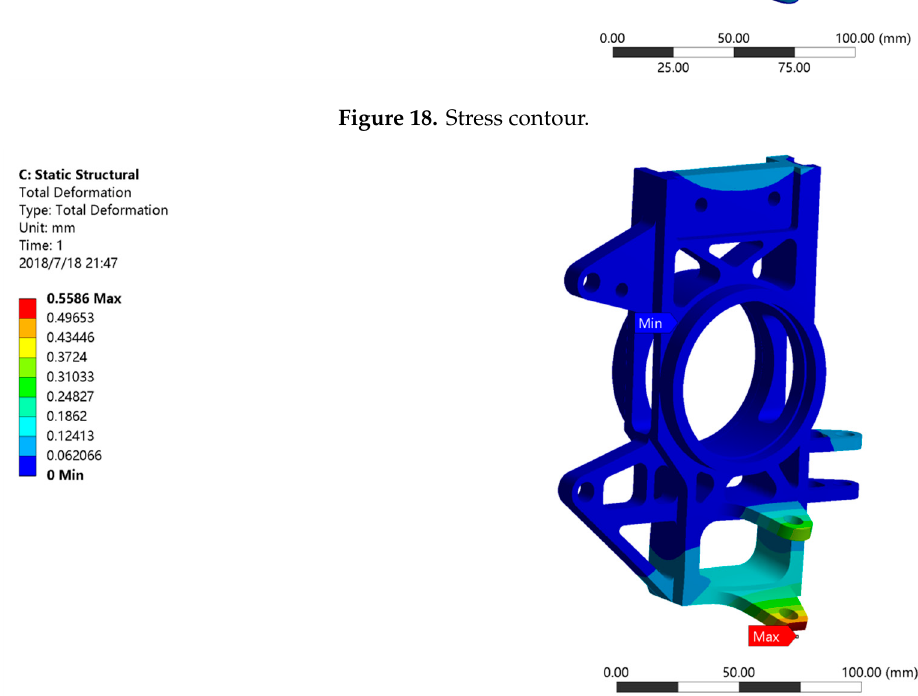
Figure 18. Stress contour.